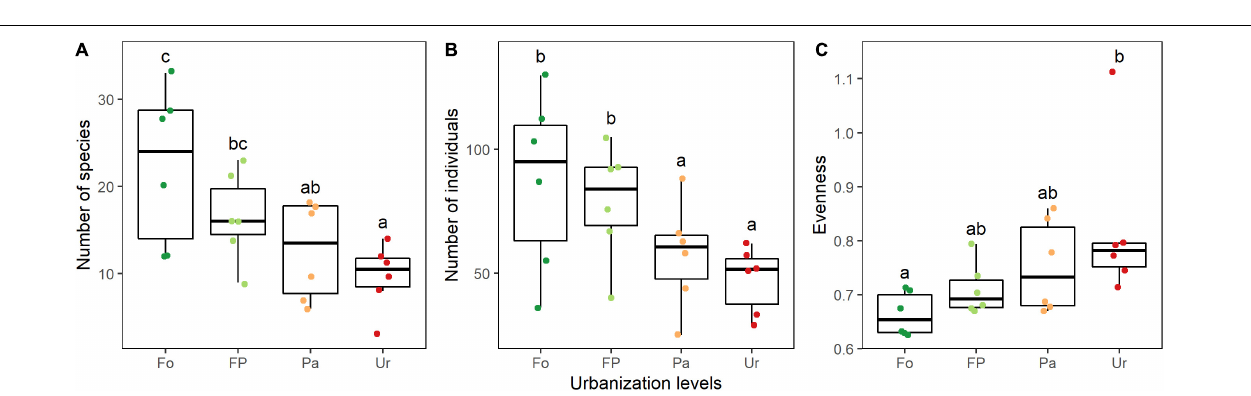
FIGURE 3 | Land-use effects on richness (A) , abundance (B) , and evenness (C) of the bird communities along an urbanization gradient in the southern Ecuadorian Andes. Data is depicted through quartiles and different lowercase letters above the whiskers indicate significant differences between land uses (GLM p < 0.05). Fo, forest sites; FP, forest-pasture sites; Pa, pasture sites; Ur, urban sites. All sampling times (two) and sites (three) for each land use are used for